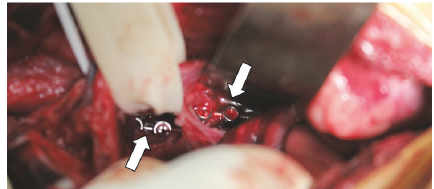
Figure 5: Intraoperative image showing paired, adjacent string of pearl plates (white